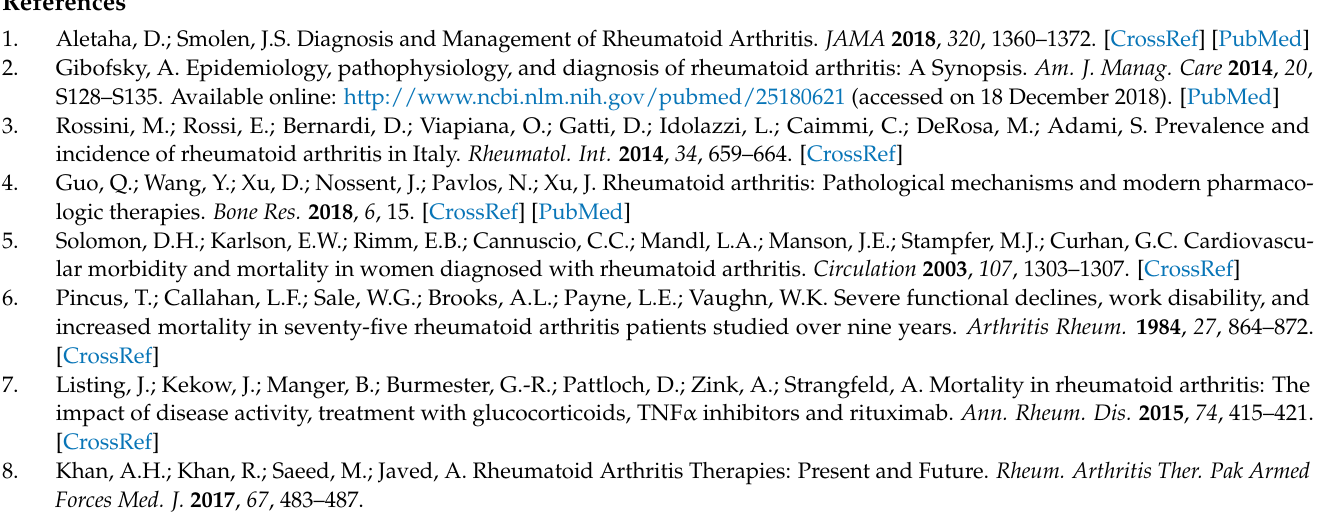
Table S2: Distribution of baseline characteristics of 829 new users of biologic DMARDs in the second- phase analysis; Figure S4: Sub-trajectories of adherence to biologic DMARDs in the second-phase analysis (sensitivity analysis); Table S3: Distribution of baseline characteristics of 829 new users of biologic DMARDs in the second-phase analysis (sensitivity